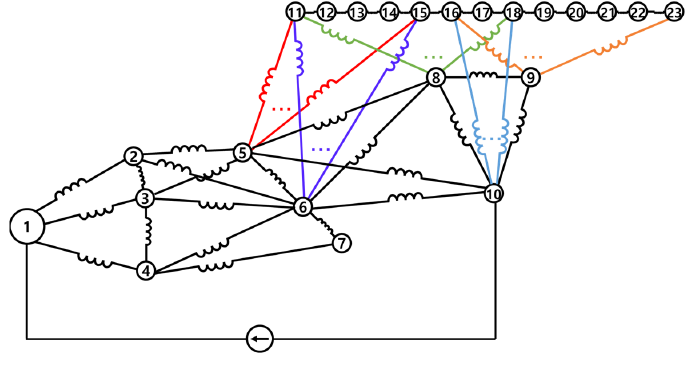
Figure 12. PSpice simulation at high side of bottom layer. ( a ) Circuit model. ( b ) Simulation result.